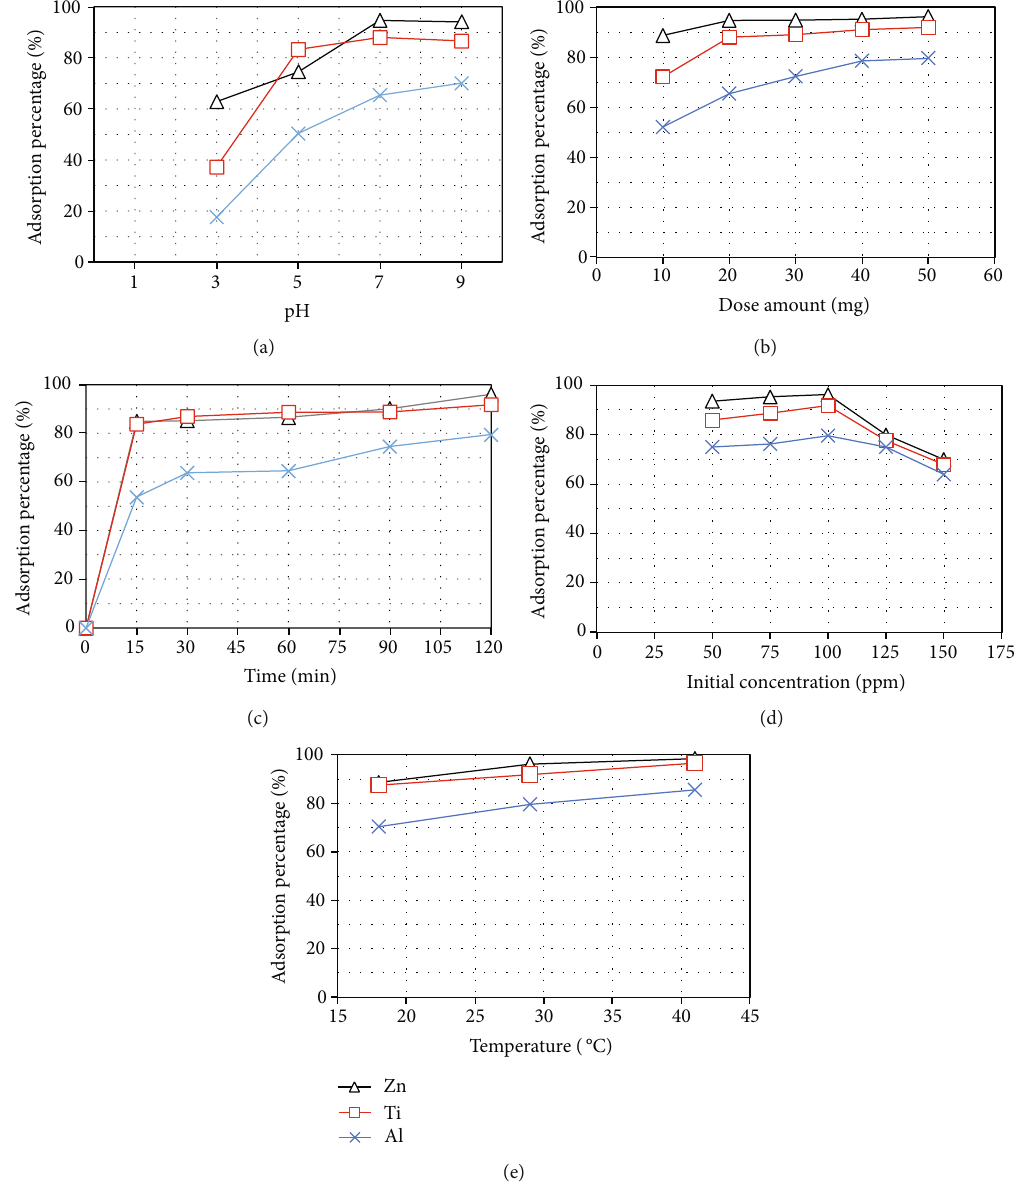
Figure 2: E ff ect of di ff erent parameters on the adsorption of Pb(II) onto all adsorbents: (a) initial pH of the solution, (b) adsorbent dosage, (c) contact time, (d) initial concentration of Pb(II), and (e)